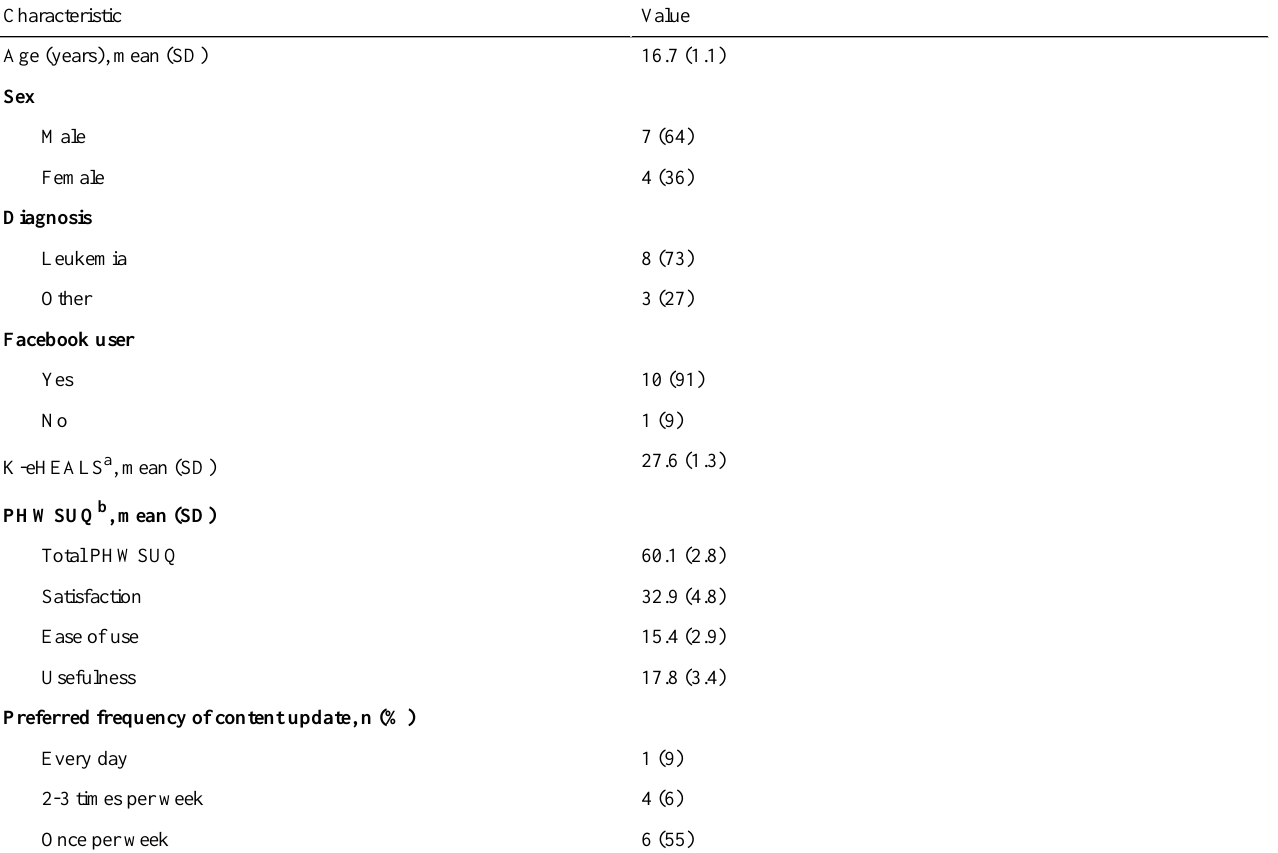
Table 4. Characteristics of user testing participants